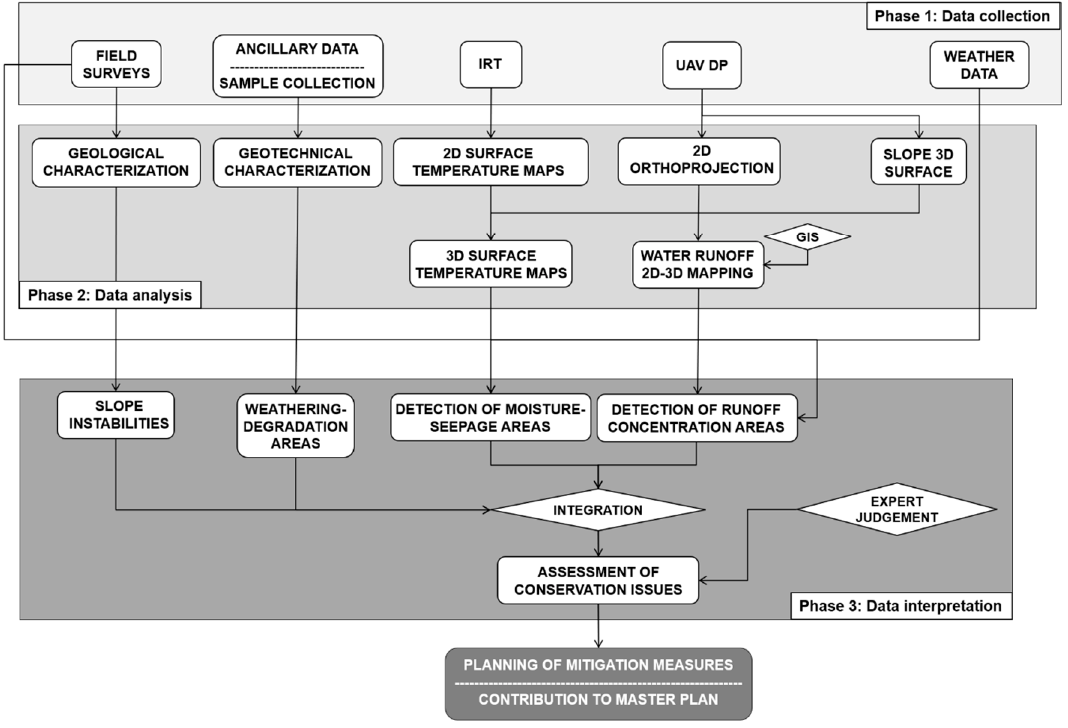
Figure 3. Work plan of the adopted methodology.